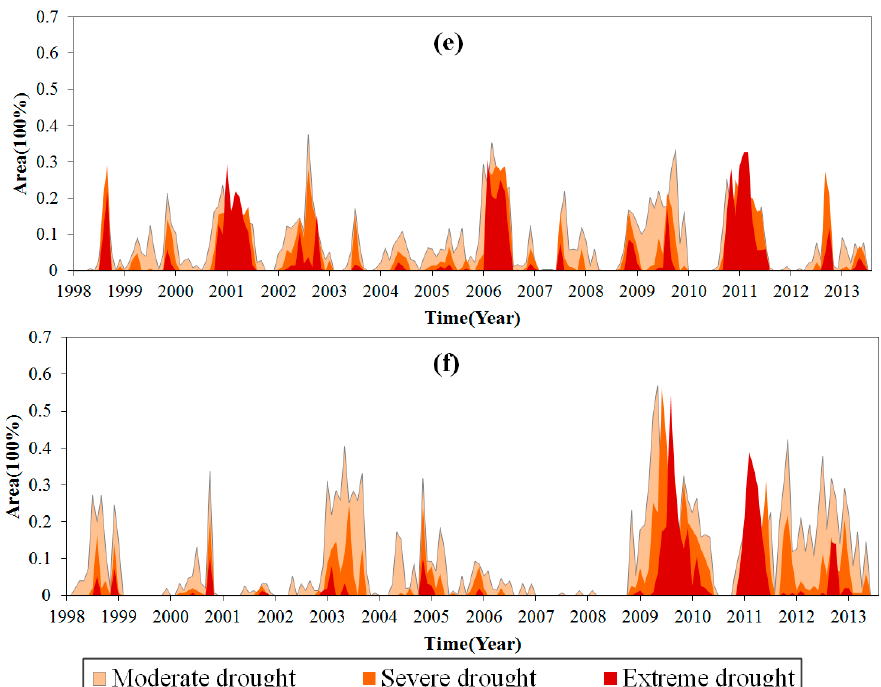
Figure 6. TRMM 3B43 for drought monitoring (SPI at time scale of six months) for different regions: ( a ) Northeast; ( b ) Huang–Huai–Hai; ( c ) MLRY; ( d ) South; ( e ) Sichuan basin; and ( f ) Southwest.